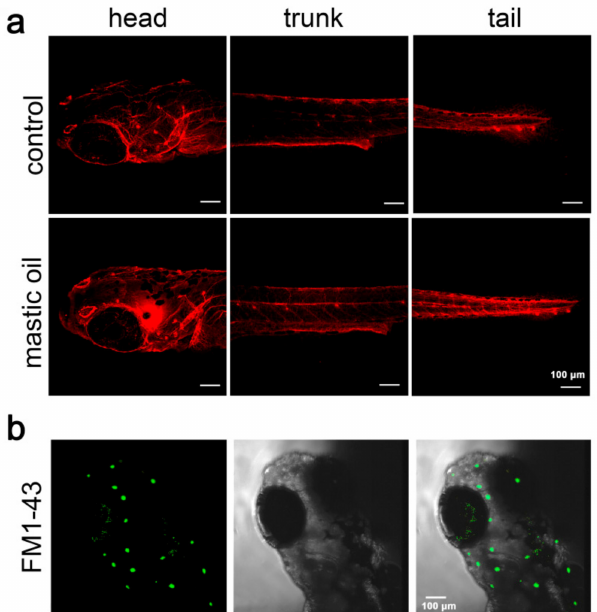
Figure 1. Architecture of the lateral line system in mastic essential oil-treated zebrafish. ( a ) Acetylated tubulin staining of control and mastic oil-treated zebrafish larvae at 7 dpf. ( b ) A representative image showing FM1-43 staining of 7 dpf zebrafish